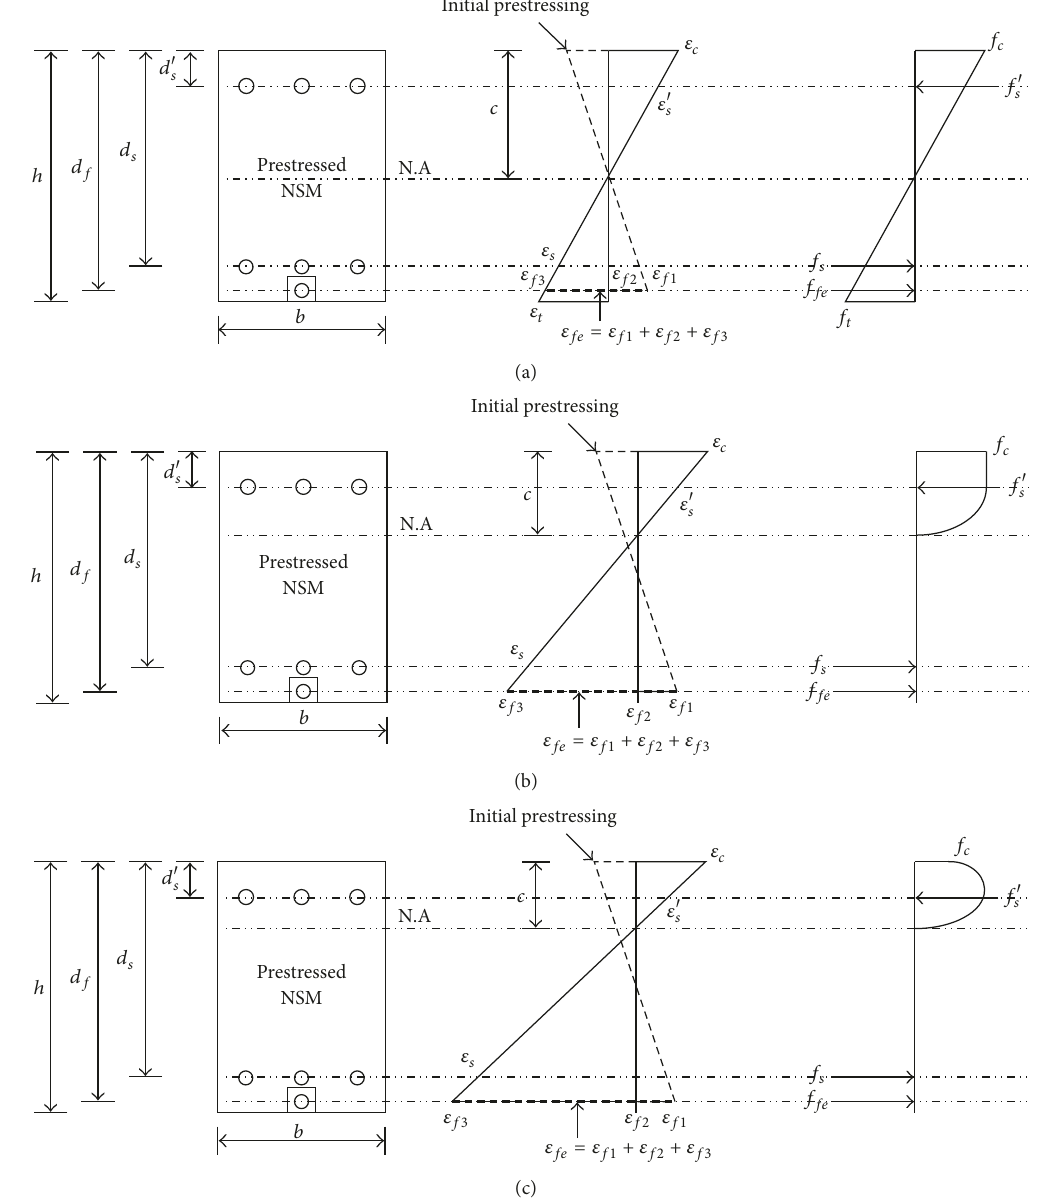
Figure 10: Load-deflection curves per analysis